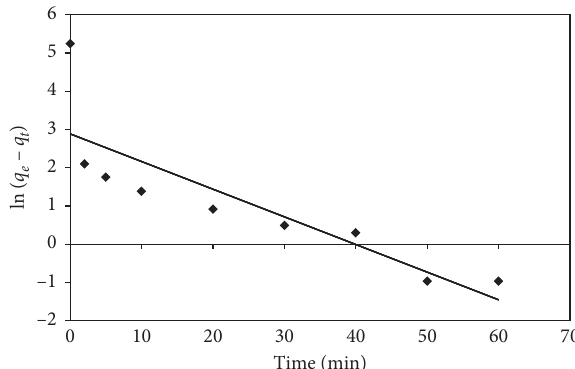
Figure 10: Crystal violet adsorption model for pseudo-first-order kinetic.